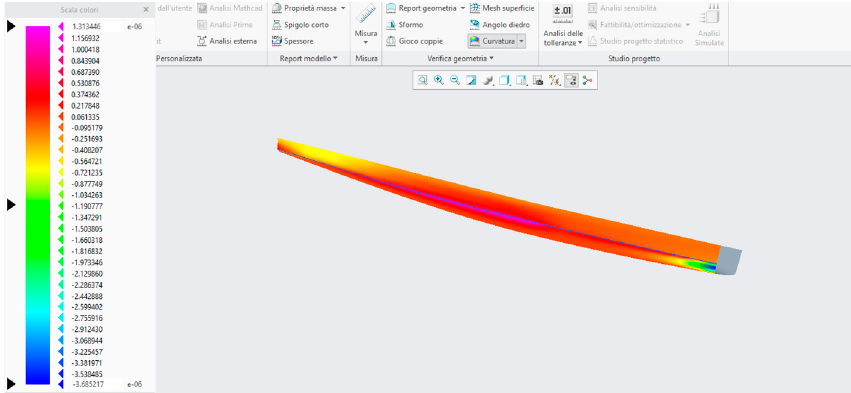
Figure 12. Curvature analysis of the surface of the hull.